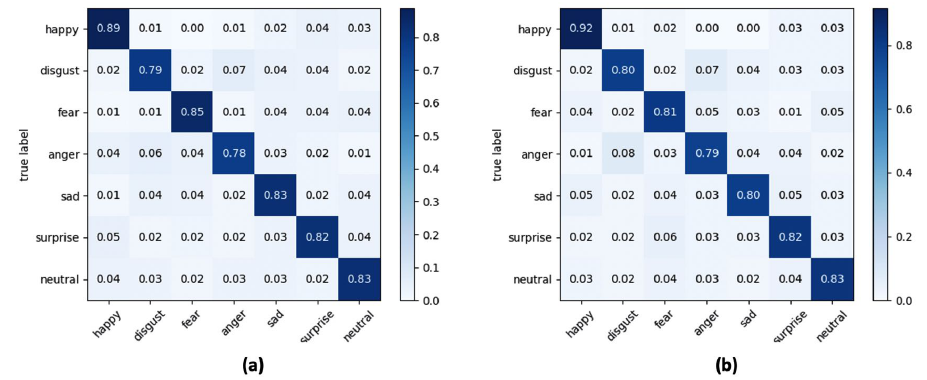
Figure 11. Confusion matrix for seven classes of facial expressions using kNN as classifier and at varying of ( a ) yaw angle and ( b ) pitch